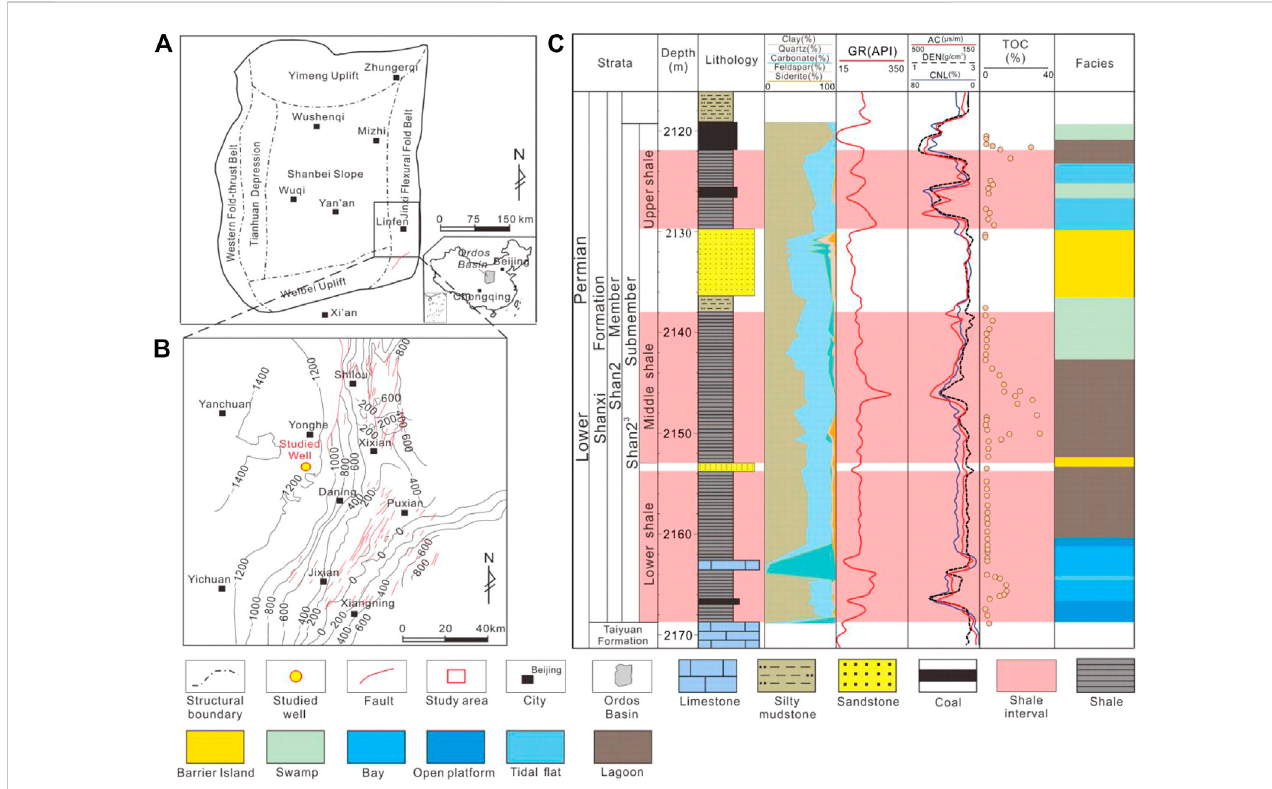
FIGURE 1 (A) Locationofstudyarea,NorthChina. (B) DistributionmapshowingtheburialdepthofShan2 3 Submembertransitionalshale. (C) Verticaldistributionof Shan 2 3 Submember transitional shale in the studied well (Facies is modi fi ed according to Zhang et al.,